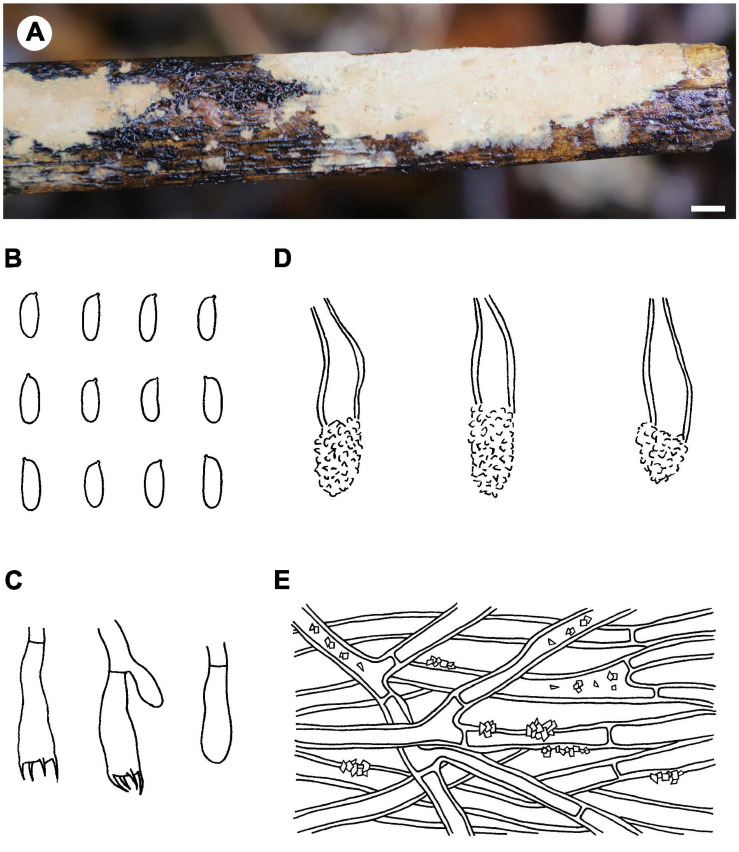
Phlebiopsis cylindrospora (from the holotype He 5984; scale bars: A = 1 cm, B–E = 10 μm). (A) Basidiomata; (B) basidiospores; (C) basidia and basidiole; (D) lamprocystidia; (E) hyphae from subiculum.